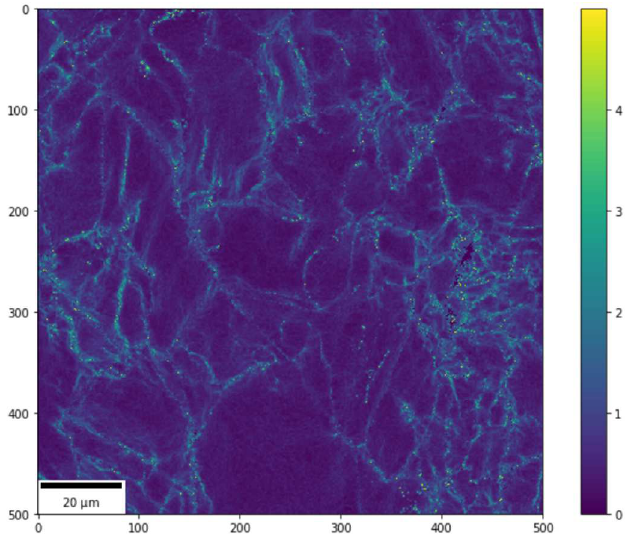
Fig. 5. Training KAM map at (cid:15) = 12% .